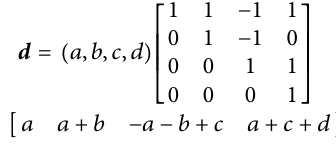
Frontiers in Genetics |